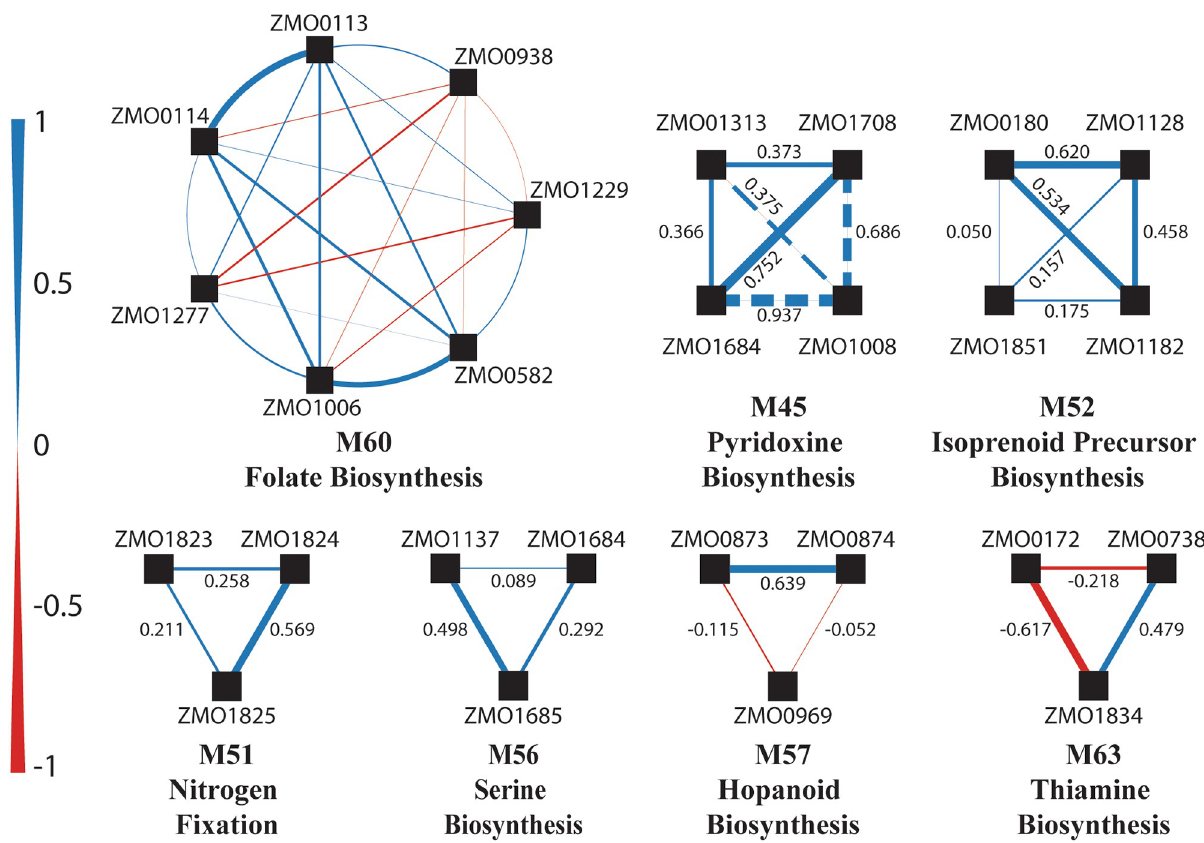
Fig 4. Pairwise cofitness in poorly correlating modules. The seven poorly correlating modules are represented as node and edge plots. Each node (black square) is a gene within the module, while each edge between nodes represents the cofitness for that pair of genes. Edges in blue represent positive cofitness and edges in red negative cofitness. Edge thickness correspond to the value of cofitness. These pairwise cofitness values are shown for smaller modules. In Module 45, the gene ZMO1008 was identified via MEGS during model development and is shown here with dashed